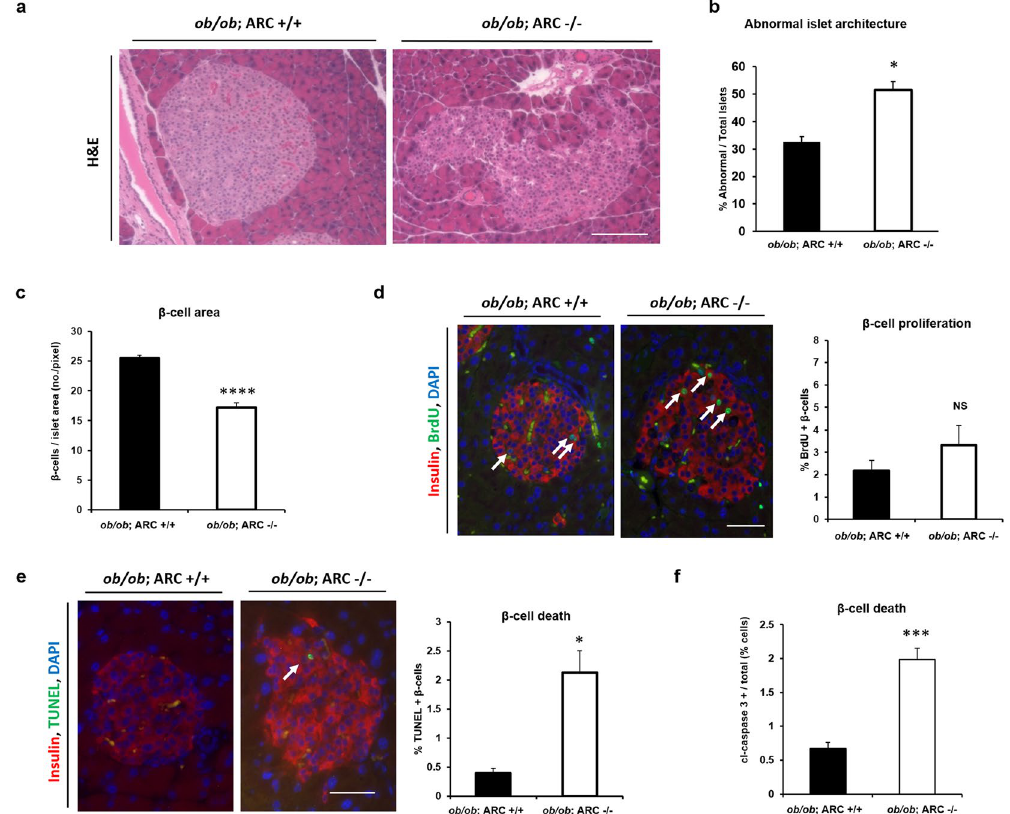
Figure 2. Deletion of ARC results in β -cell death and abnormalities in islet architecture in ob/ob mice. ( a ) Hematoxylin and eosin (H&E) staining of pancreatic tissue from 24 week old mice. Scale bar 100 μ M. ( b ) Percentage of abnormal islets as determined from H&E staining. ( c ) β -cell area. ( d ) β -cell proliferation as determined by incorporation of BrdU into nuclei of insulin-positive cells. Arrows demarcate BrdU-positive β -cells. Scale bar 50 μ M. ( e ) and ( f ) β -cell apoptosis as determined by TUNEL (panel e) and percentage of β -cells with cleaved (cl) caspase-3 (panel f). In panel e, arrow indicates TUNEL-positive β -cell, and scale bar 50 μ M. NS is not significant. * P < 0.05, *** P < 0.001, and **** P <